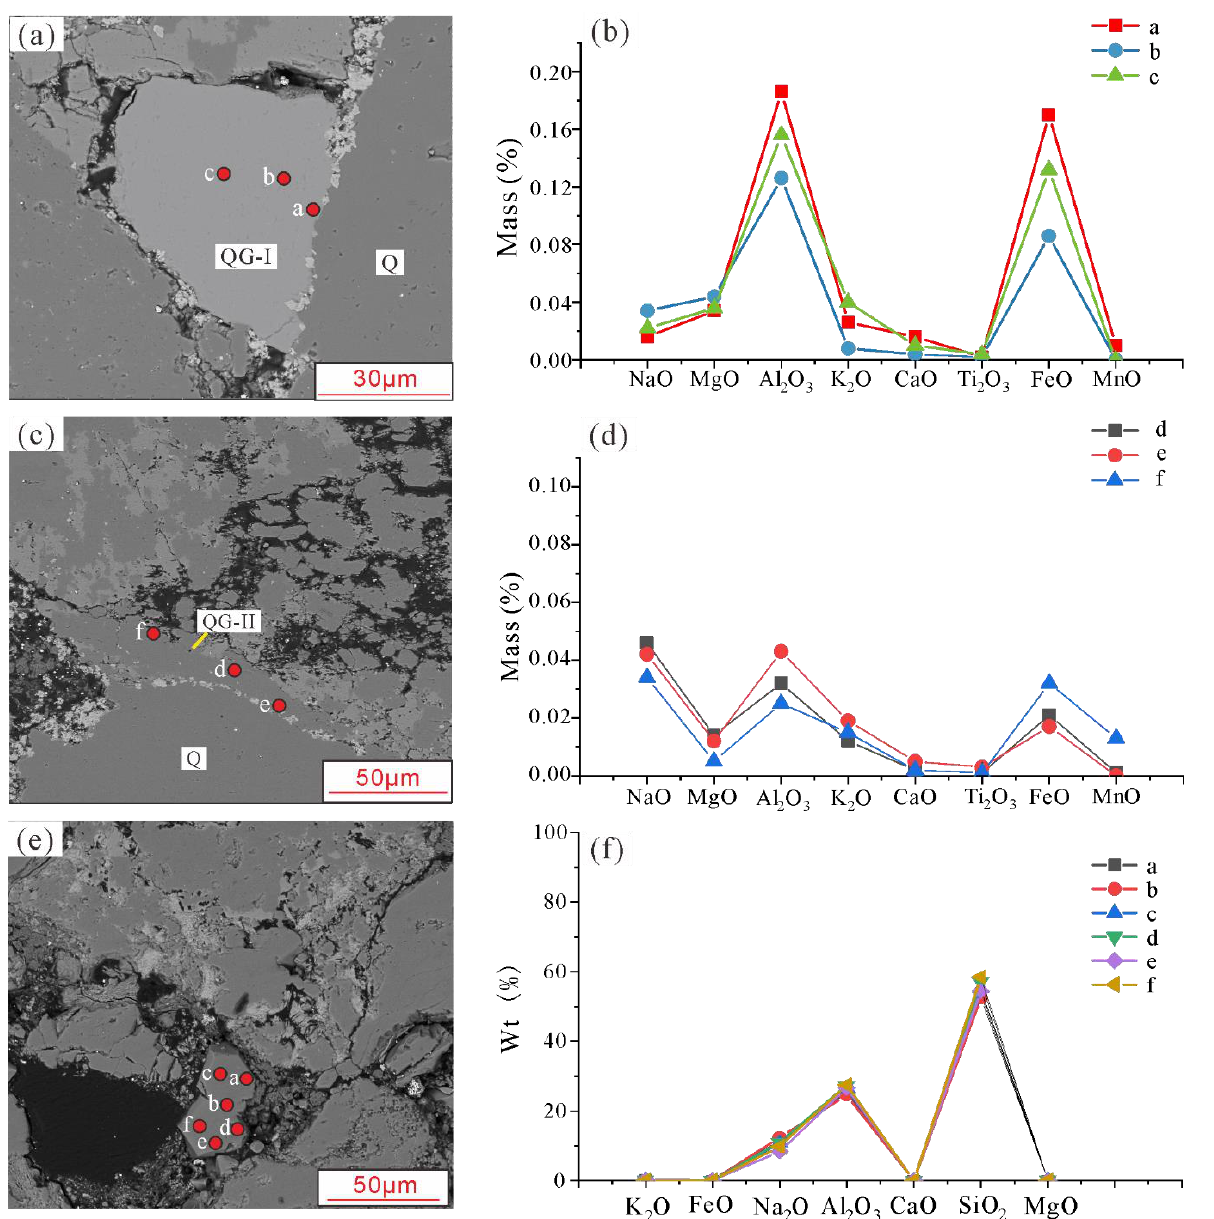
Figure 7. In situ microprobe analysis for quartz and zeolite in the Toutunhe Formation sandstone. ( a ) Backscattered electron image exhibiting experimental point situations of quartz for the sample 3643.2 m, well X1; ( b ) elemental composition distribution features of a quartz grain in sample 3643.2 m, well X1; ( c ) backscattered electron image exhibiting experimental point situations of quartz for the sample 3907.4 m, well X1; ( d ) elemental composition distribution characteristics of a quartz grain in sample 3907.4 m, well X1; ( e ) backscattered electron image exhibiting experimental point situations of zeolite for the sample 3710 m, well X1; ( f ) elemental composition distribution features of a zeolite grain in sample 3710 m, well X1.